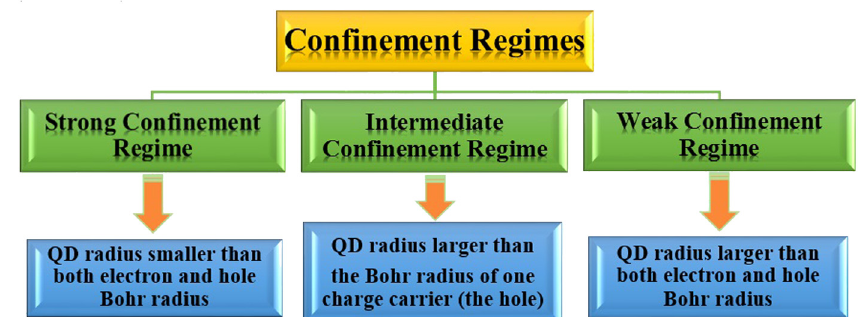
Scheme 1: Di ff erent QD con fi nement regimes.